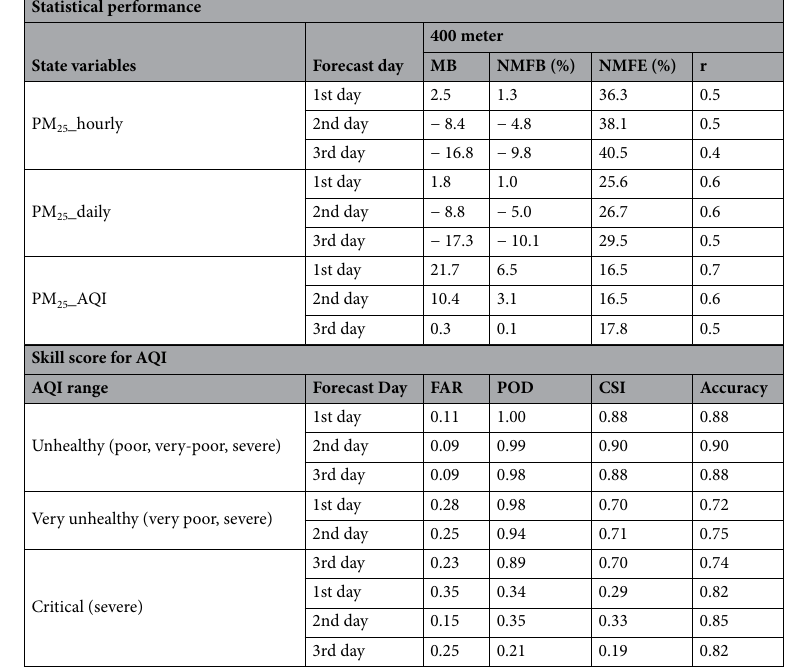
Table 1. Performance statistics for mean PM 2.5 forecast and skill score for different forecast AQI category over Delhi during 21 October 2019 to 01 February